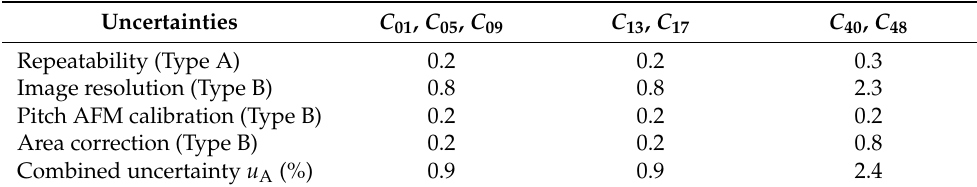
Table 4. Relative uncertainties (%) for area measurements on MC2 capacitors.